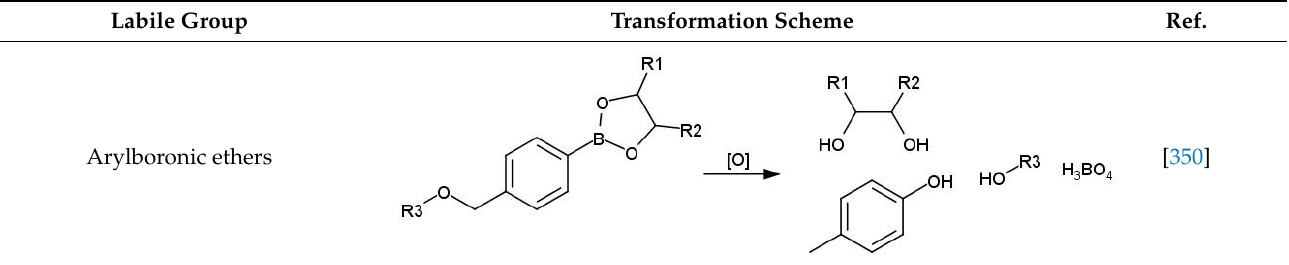
Table 3. Cont. Labile Group Transformation